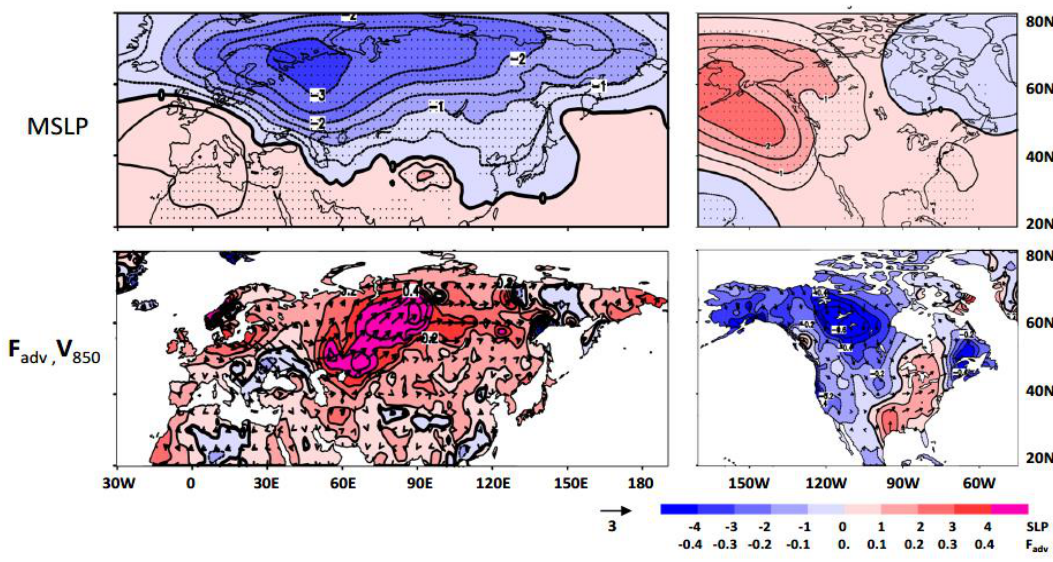
Figure 11. Anomalies of ( top ) MSLP (interval 0.5 hPa) and ( bottom ) 850-hPa horizontal temperature advection (F adv , shading and contour interval 0.1 °C day −1 ) and vector winds (V 850 , arrows; ms −1 with a scale shown in the bottom; anomalies less than 0.1 ms −1 in both directions are omitted) regressed upon the linearly de-trended and standardized cyclone activity series. The cyclone activity series used is ( left ) the cyclone count series over Eurasia and (right) the cyclone intensity series over North America. Black dots indicate SLP anomalies that are significantly different from zero at the 5% level. Results are based on the ensemble mean JFM fields over the period